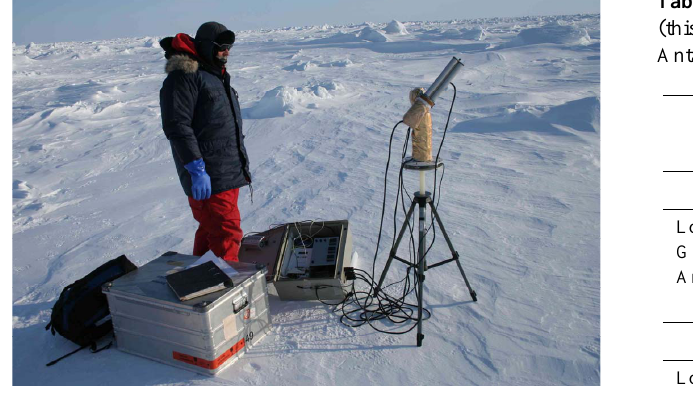
Figure 6: The CIMEL sun photometer CE 318 equipped with additional heating and thermal insulation 7 (golden color) during sky observations on the Arctic sea ice near Tara at about 88°N. . Fig. 6. The CIMEL Sun photometer CE 318 equipped with addi- tional heating and thermal insulation (golden color) during sky ob- servations on the Arctic sea ice near Tara at about 88 ◦ N.